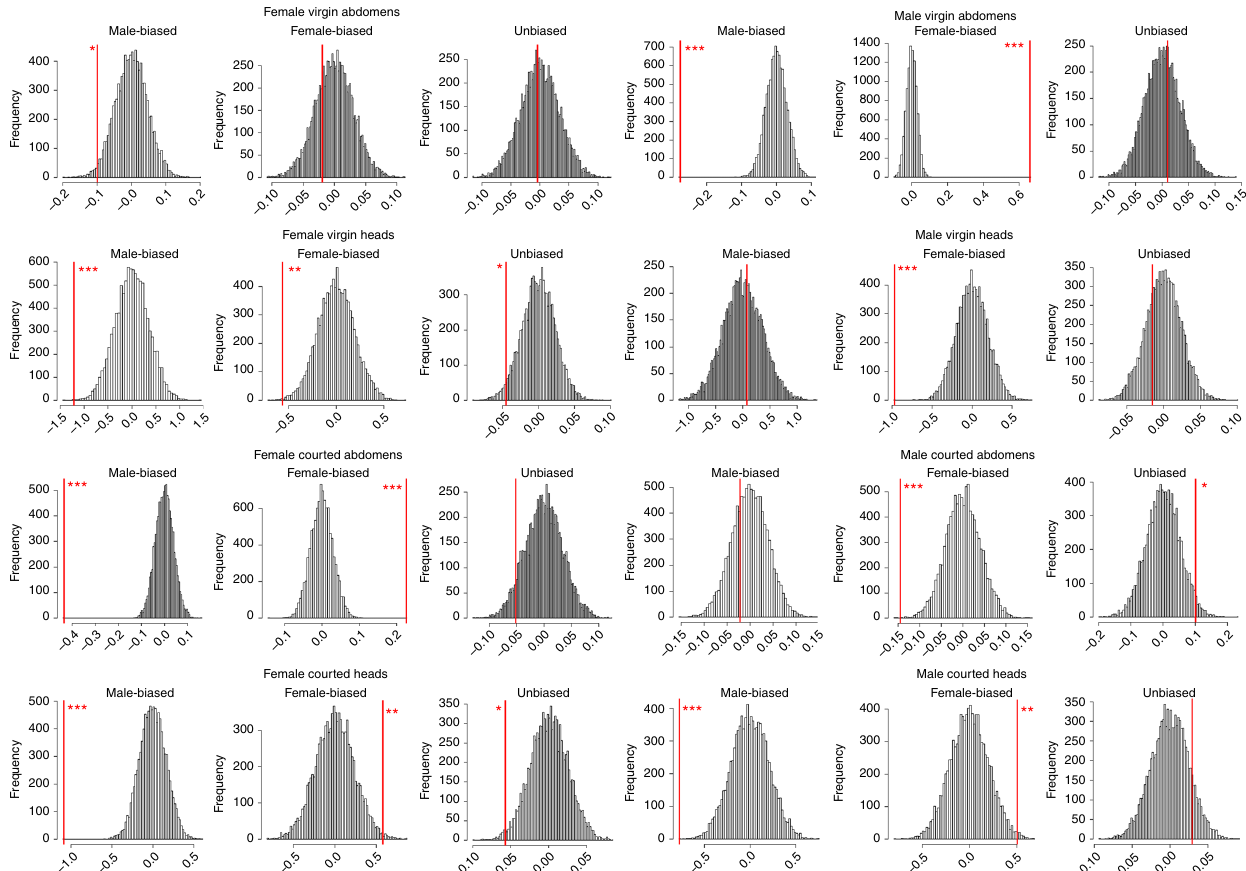
Fig. 2 Results of the balanced randomisation analysis of gene expression changes. Histograms summarise 10,000 iterations of switching the sign of stdLogFC. Red bars indicate the observed mean stdLogFC. Positive values in the x axis indicate higher expression under Polygamy. Stars indicate the proportion of iterations with a more extreme value than the observed (*** < 0.001, ** < 0.01, * <